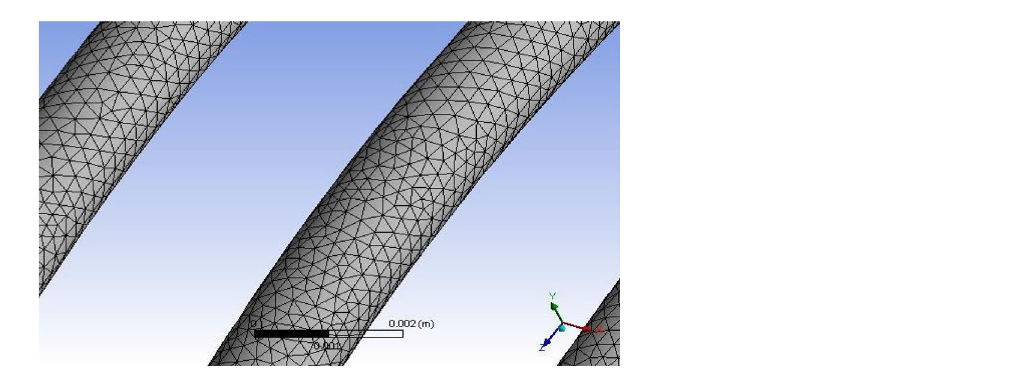
Figure 5. Tetrahedron